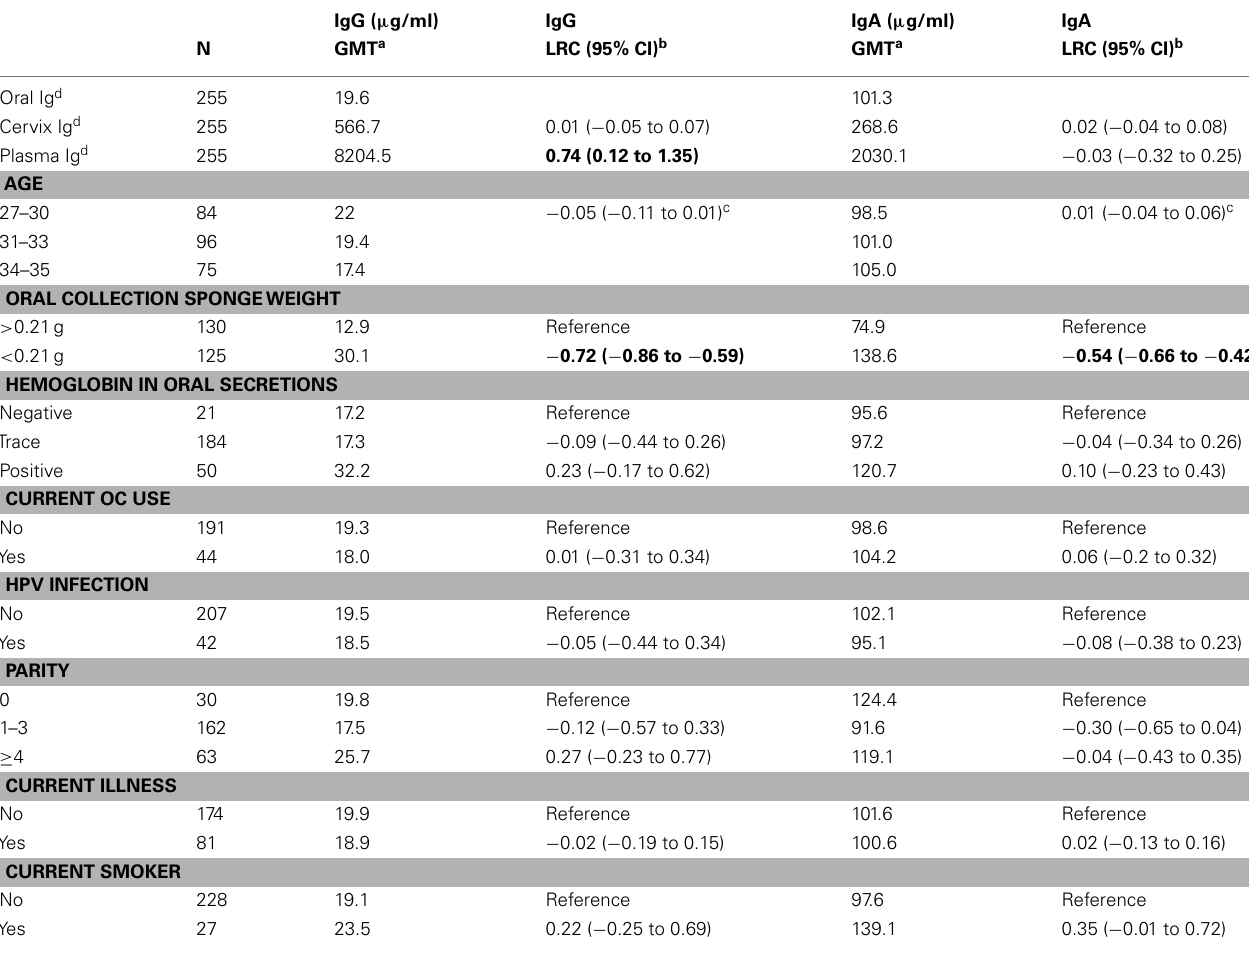
Table 1 |Association between covariates of interest and oral IgG and IgA ( µ g/ml)